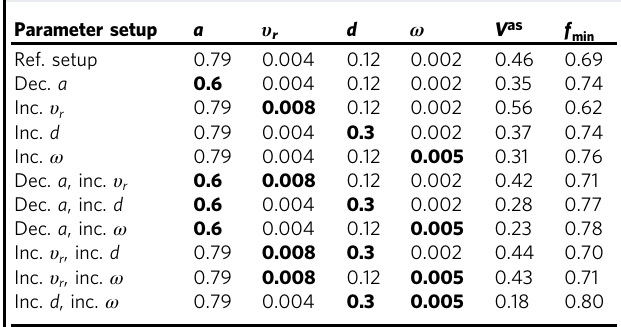
Table 1 Asymptotic level of immunization V as and